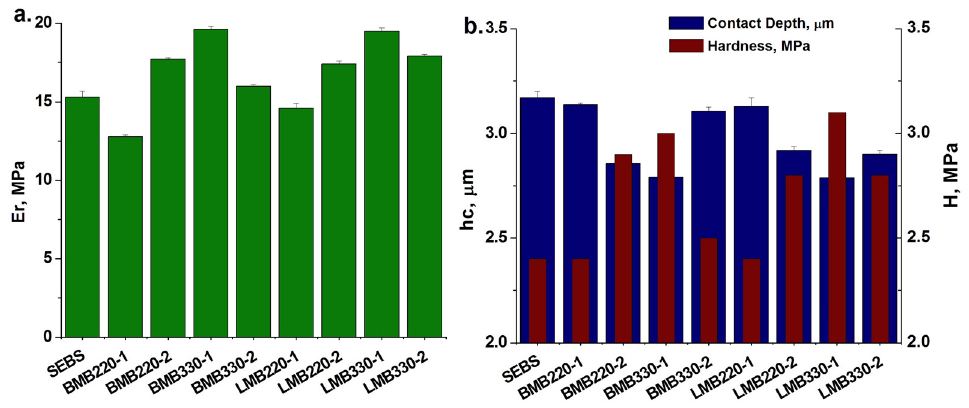
Figure 6. Reduced modulus ( E r ) ( a ), hardness ( H ) and contact depth ( h c ) ( b ) of masterbatches processed in Brabender and Leistritz extruders in comparison with SEBS.